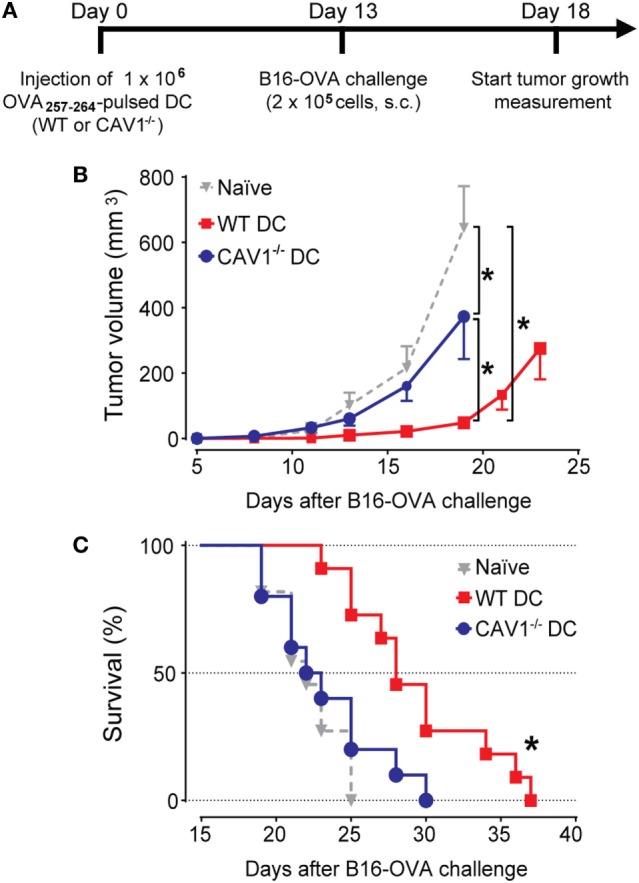
Caveolin-1 (CAV1) promotes dendritic cell (DC)-mediated antitumor protection. (A) Scheme showing experimental procedure. Initially, 1 × 106 OVA257–265-pulsed wild-type (WT) or CAV1−/− BM-DCs were transferred to WT recipient mice. The control group was injected with PBS (vehicle). After 13 days, mice were challenged s.c. with 2 × 105 B16F10-OVA (B16-OVA) cells injected into the right flank. Tumor growth evaluation started 5 days after challenge and was carried out until all the animals were dead. The animals were sacrificed when the length, width, or height surpassed 15 mm. Groups were defined as: control mice group (gray triangles), OVA257–265-loaded WT (WT DCs, red squares), and OVA257–265-loaded CAV1−/− DCs (CAV1−/− DCs, blue circles). (B) Average tumor growth curves are shown (*p < 0.05, t-test, n = 8–10 mice). (C) Survival curves. The mean survival times were as follows: Ctrl group, 22 days; WT DC group, 28 days; CAV1−/− DC group, 22,5 days (*p < 0.05, n = 8–10 mice, three different experiments).